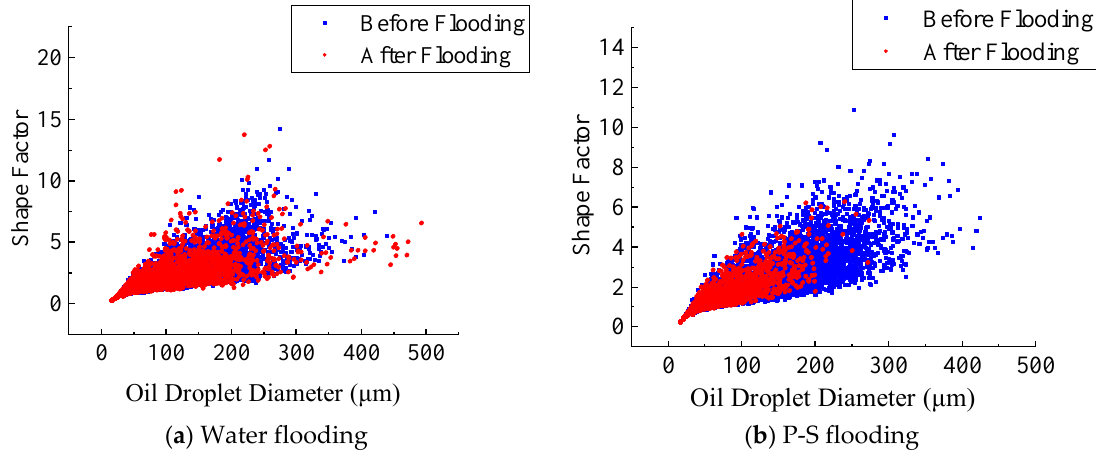
Figure 8. Change in shape factor of residual oil droplets in the No. 1 rock sample.